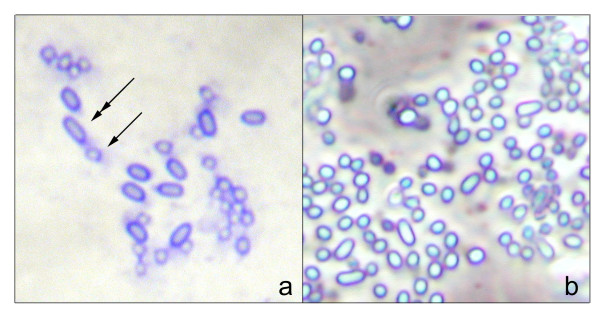
Poorly staining crystals. Stained (a) and Phase Contrast (b) micrographs of Bt1-32 showing spores (double arrow) and relatively lightly staining crystals (single arrow).